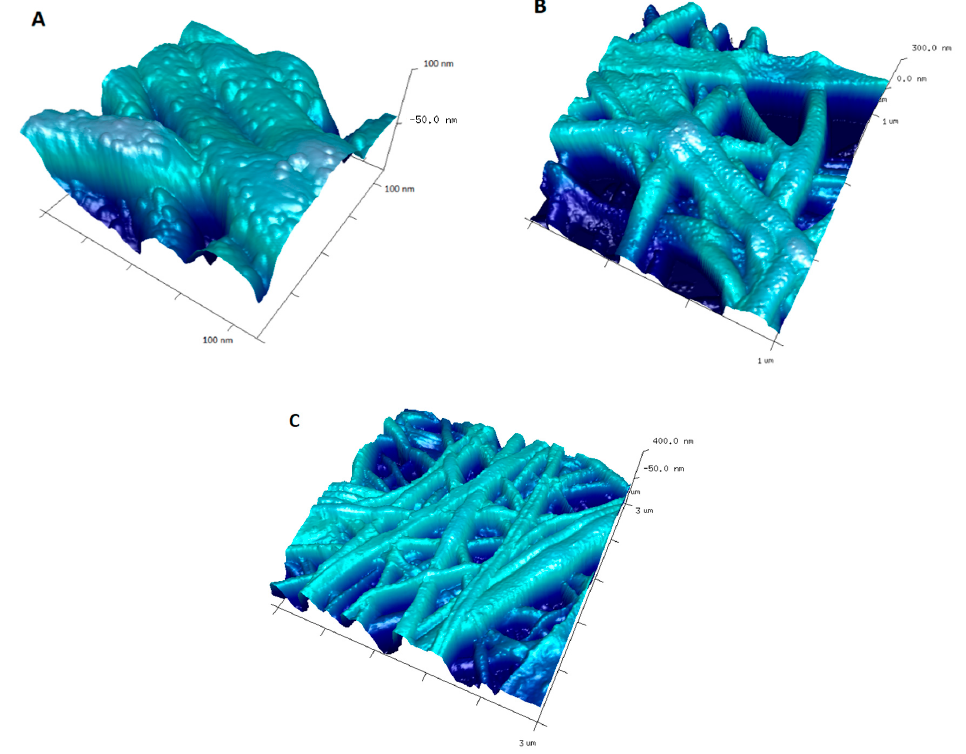
Figure 9. AFM 3D images representing the topography of BP/AgP nanocomposites at various Figure 9. AFM3DimagesrepresentingthetopographyofBP / AgPnanocompositesatvariousmagnifications, magnifications, ( A ) zoomed area from 1 × 1 µm region, ( B ) full 1 × 1 µm region and ( C ) 3 × 3 µm ( A ) zoomed area from 1 × 1 µ m region, ( B ) full 1 × 1 µ m region and ( C ) 3 × 3 µ m region.